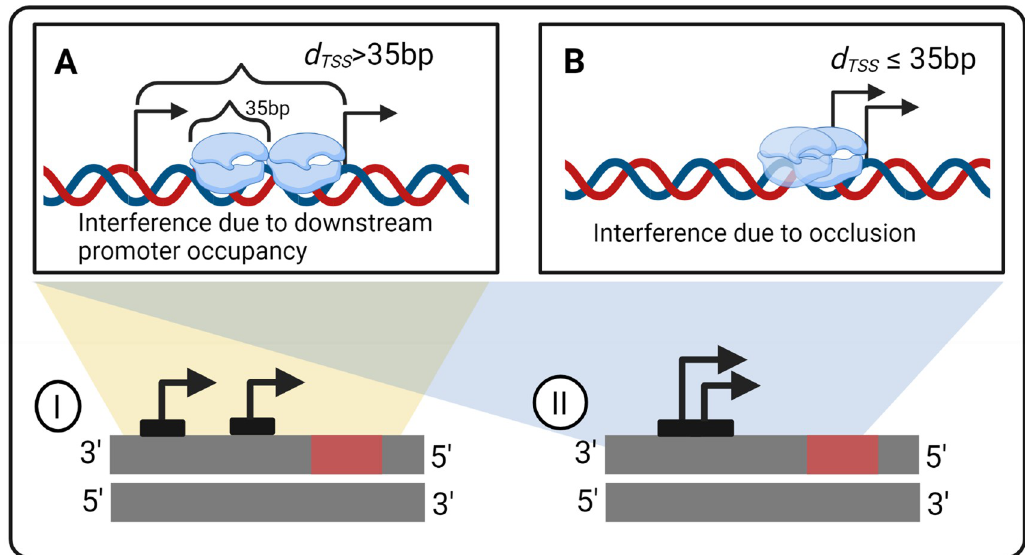
Fig 1. Interference between tandem promoters with different arrangements relative to each other. (A) Interference by an RNAP occupying the downstream promoter on the activity of the elongating RNAP from upstream promoter. The TSSs need to be at least 36 bp apart (the length occupied by an RNAP when in OC, [23,25]) (B) Interference by occlusion of one of the promoter’s TSS by an RNAP on the TSS of the other promoter. The distance between the TSSs need to be � 35 bp apart. Blue clouds are RNAPs. Black arrows sit on TSSs and point towards the direction of transcription elongation. Arrangements (I-II) of two promoters studied in the manuscript in tandem formation are represented. The red rectangles are the protein coding regions. We studied only the natural tandem promoters that neither overlap with nor have in between another gene (arrangements I and II, which differ based on whether the promoter regions overlap or not). Other arrangements (not considered in this study) are shown in Fig A in the S2 Appendix. Figure created with BioRender.com.